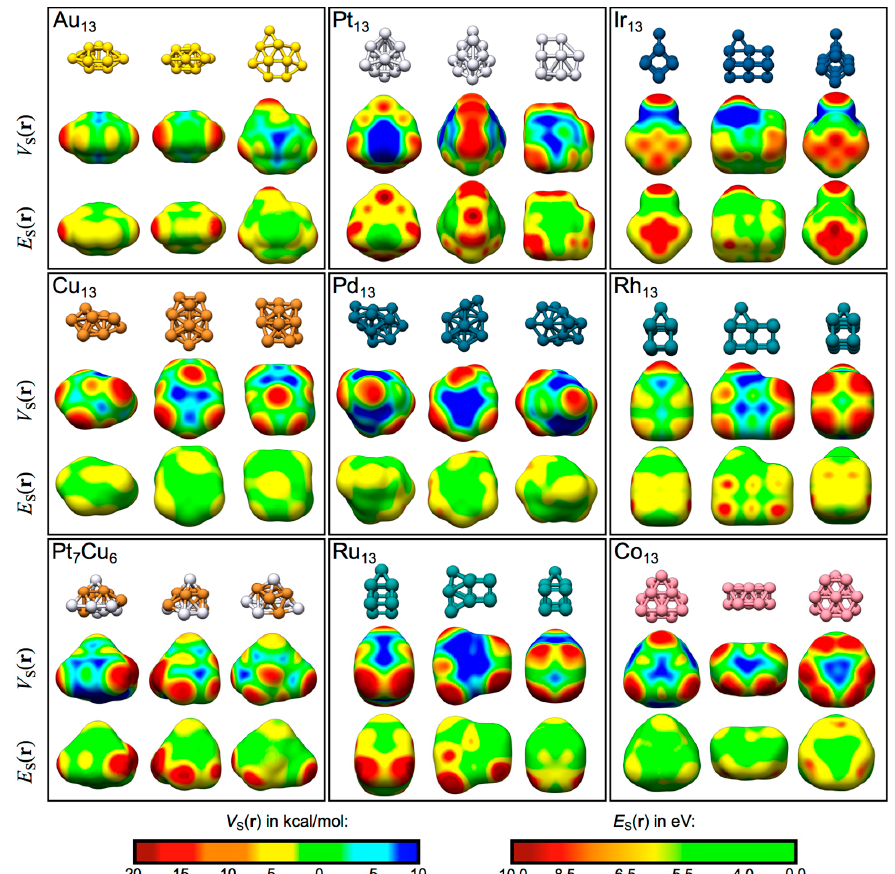
Figure 4. The TM 13 nanoparticles shown from different angles with the corresponding V S ( r ) and E S ( r ) maps obtained at the 0.001 a.u. isodensity surface. The color code is inserted in the bottom right corner. Red and yellow site correspond to Lewis acidic sites, while cyan and blue sites are Lewis basic. Values for the V S,max and E S,min are given in the supplementary material (Table S4).